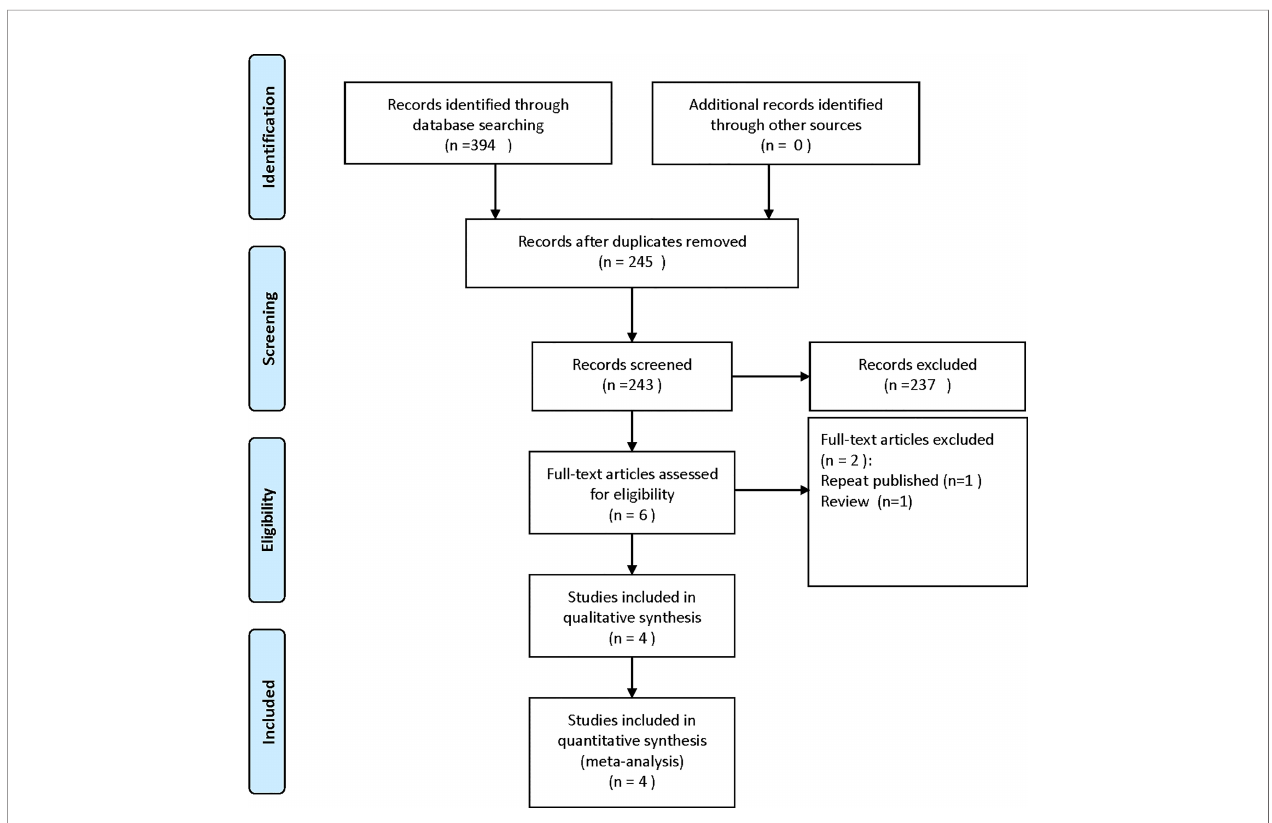
FIGURE 1 | Flow chart of selection